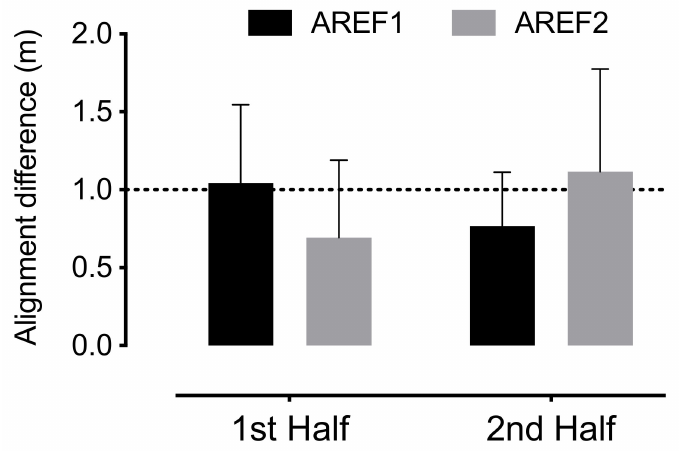
Figure 4. Alignment of the assistance referees (AREF) with the 2nd last